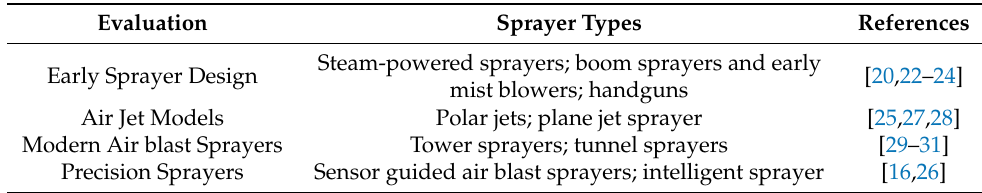
Table 1. Revolution of sprayers used in orchard spraying.